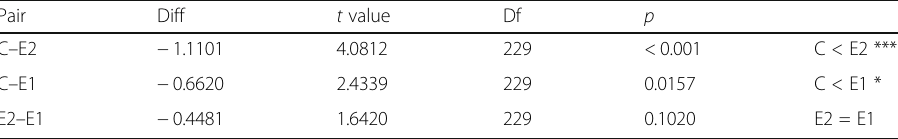
Table 21 Holm ’ s sequentially rejective Bonferroni procedure result for Material 3 Pair Diff t value Df